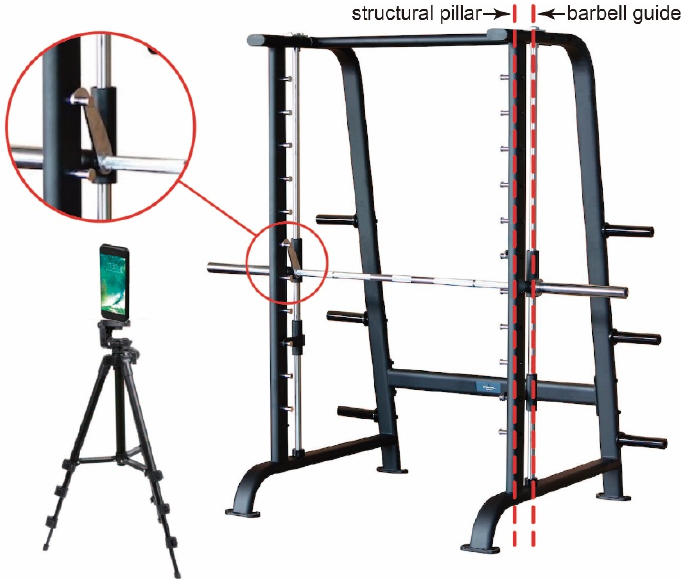
Figure 1. Experimental setup composed of a smartphone with a tripod in front of a multipower machine. Note that the structure and guide planes are parallel (dashed red lines) and that guides need to be clear to allow for a guided movement of the barbell.